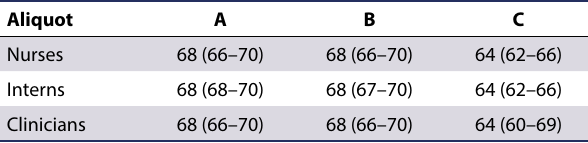
Table I: Median and range of the refractometric total proteins (g/L) obtained for each aliquot by the operators grouped by job role – aliquots A, B and C were obtained by dividing a pooled sample created from leftover plasma from canine patients presented at